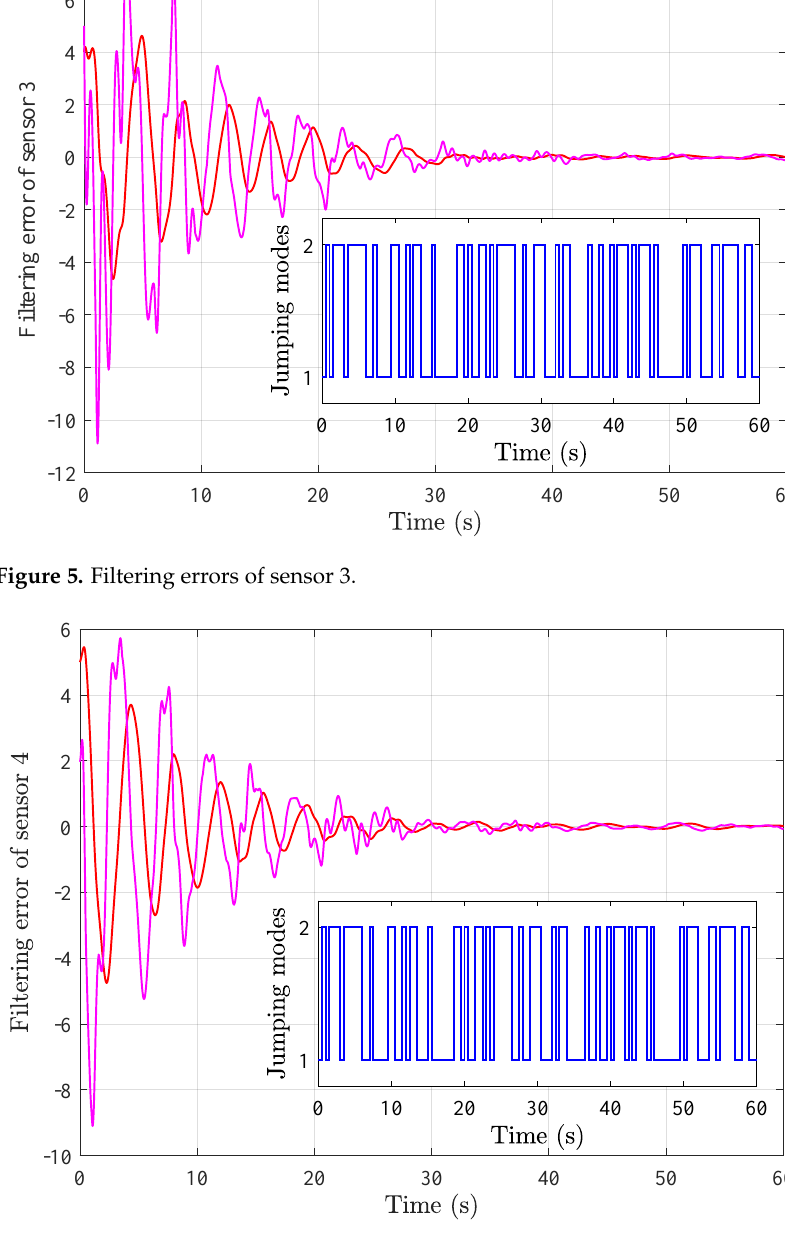
Figure 6. Filtering errors of sensor